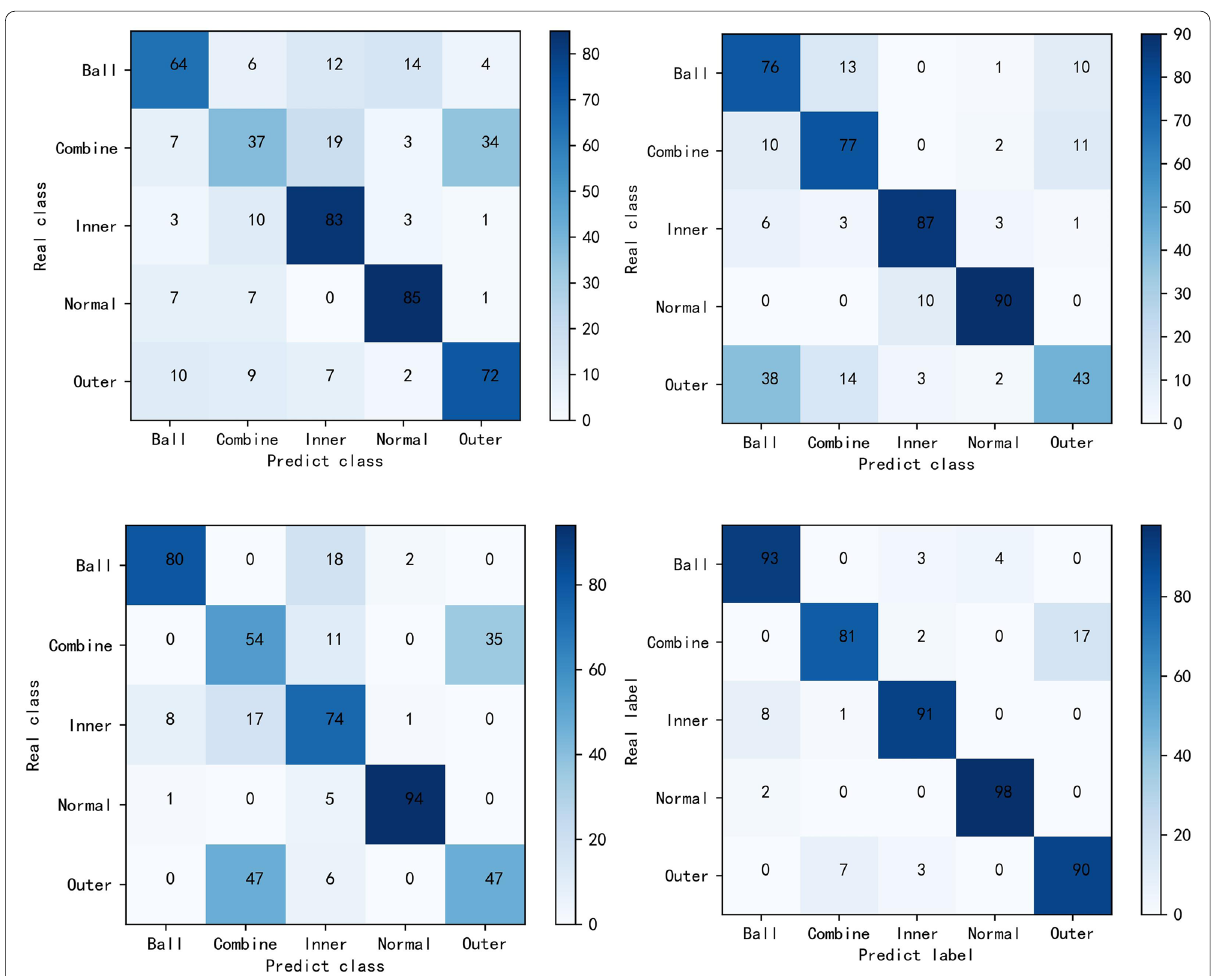
Fig. 12 Confusion matrix of diagnostic results of various methods under Training set B. (Upper left) (a) 1D CNN (Upper right) (b) Prototype network (Lower left) (c) Siamese network (Lower right) (d) ISNN